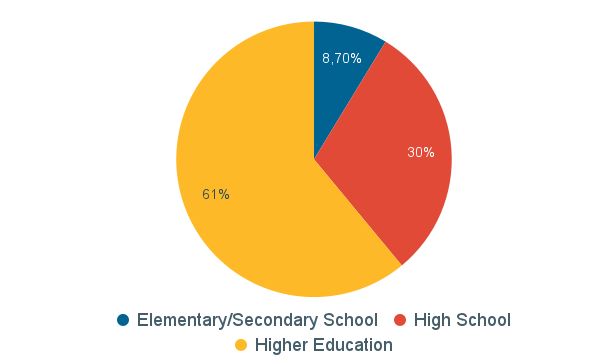
Figure 15. Level of education - Test 2.